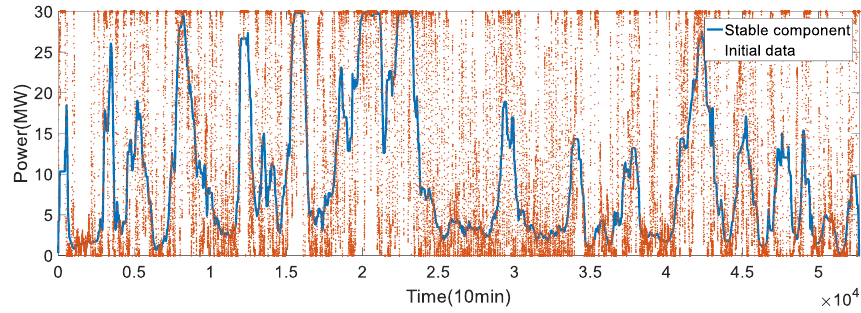
Figure 1. The distribution map of the historical annual mean wind power output data.